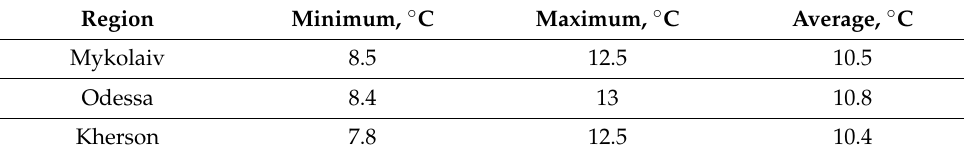
Figure 4. Average annual air temperature in the Southern regions of Ukraine. Table 5. Air